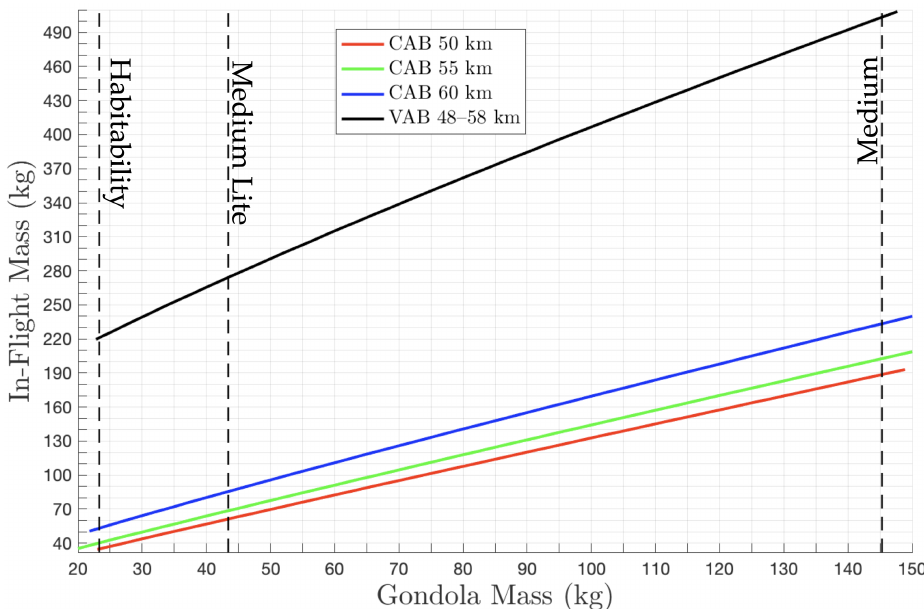
Figure 5. In-flight mass as a function of gondola mass for various Thin Red Line balloons based on calculations provided by Thin Red Line Aerospace Ltd., Chilliwack, BC, Canada. The x-axis represents gondola mass in kg. The y-axis represents total in-flight mass in kg. For CABs between 50 km and 60 km, the mass penalty for increasing float altitude is on the order of 1 kg/km. For every kg of mass added to the gondola, we see approximately 1.5 kg added to the in-flight mass. A 48–58 km VAB has an in-flight mass at least 160 kg greater than the heaviest CAB accommodating the same